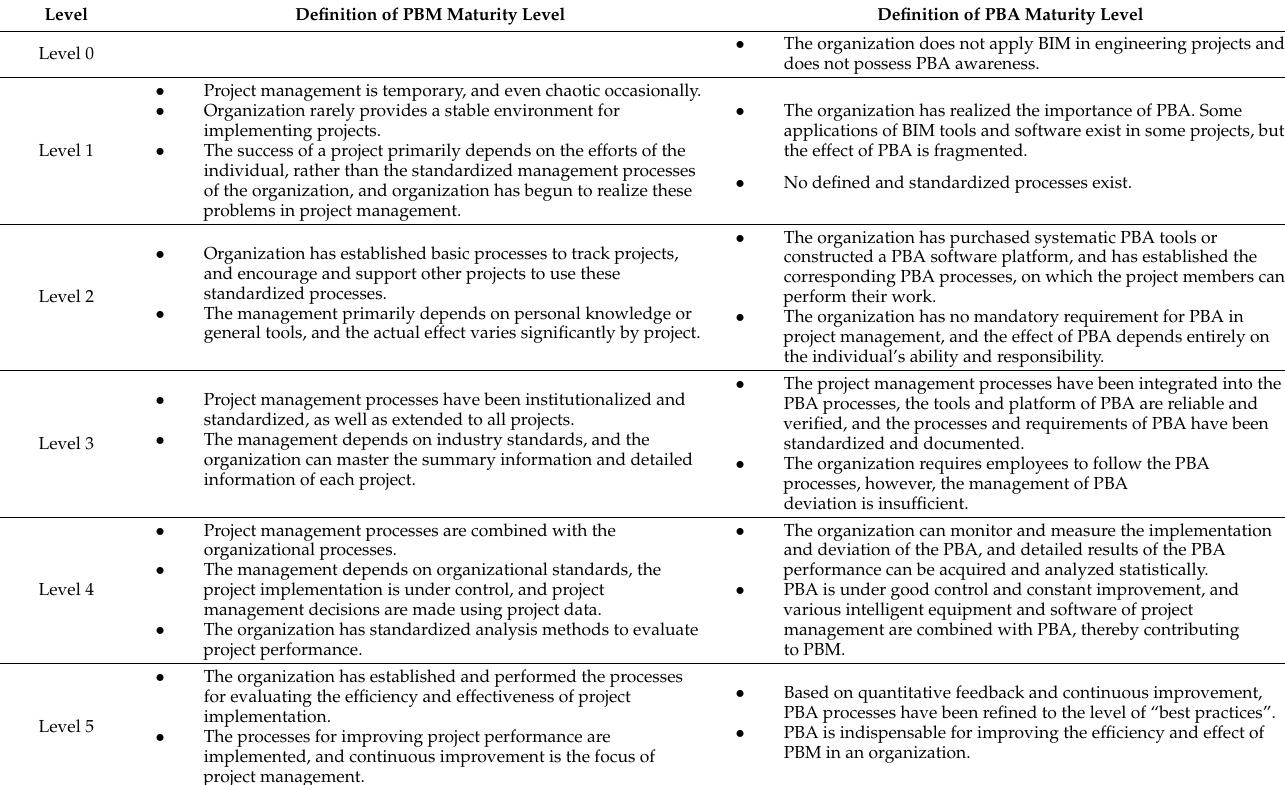
Table 1. Definition of maturity